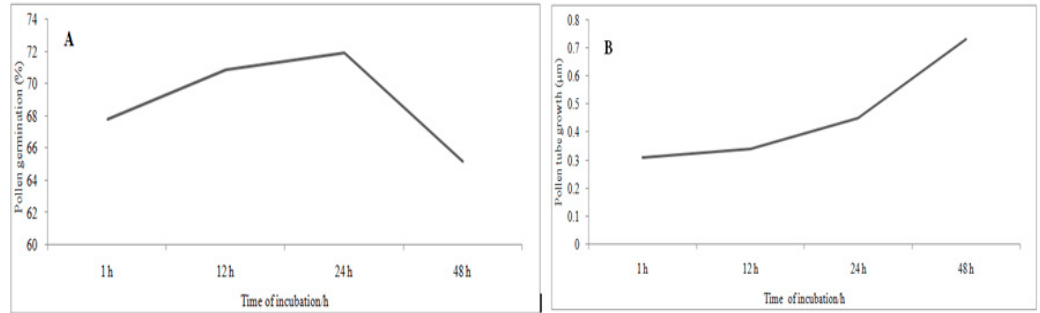
Figure 4. Effect of incubation time on pollen germination and tube growth. ( A ) The effect of incubation time on pollen germination and ( B ) The effect of incubation time on pollen tube growth.